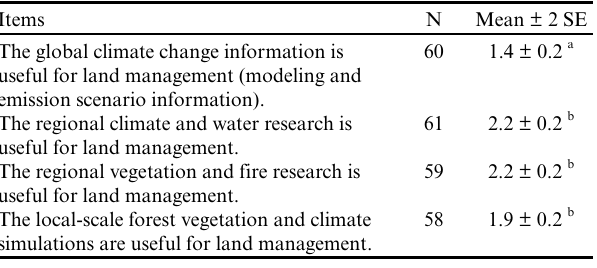
Table 1 . Mean score for each statement about the usefulness of climate change (-3 to +3, strongly disagree to strongly agree) ± 2 standard errors. An analysis of variance with Tukey’s post hoc tests was performed to determine the statistical significance of differences in mean ratings between each type of information. Superscripts that differ indicate values that differ at alpha =